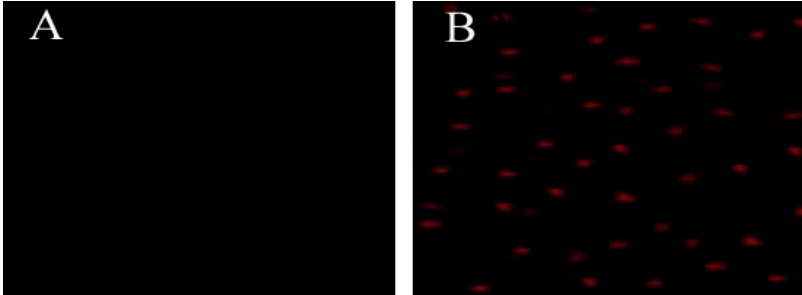
Figure 4. Effect of hLYS on H. pylori membrane permeabilization. H. pylori was incubated with ( A